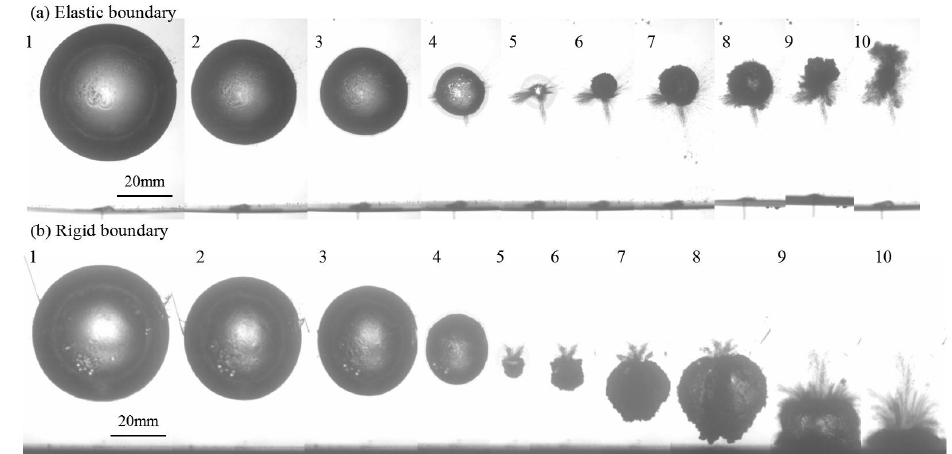
Figure 12. The bubble migration near the elastic and rigid boundaries for γ = 1.68 and R m = 20.0 mm.